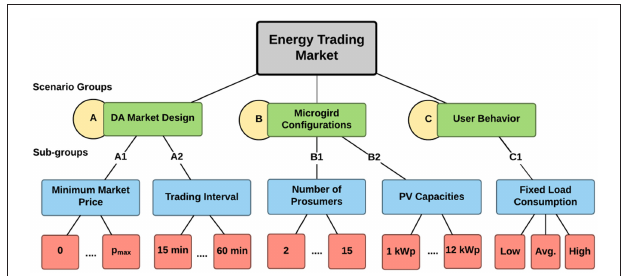
FIGURE 2 | An overview of the model